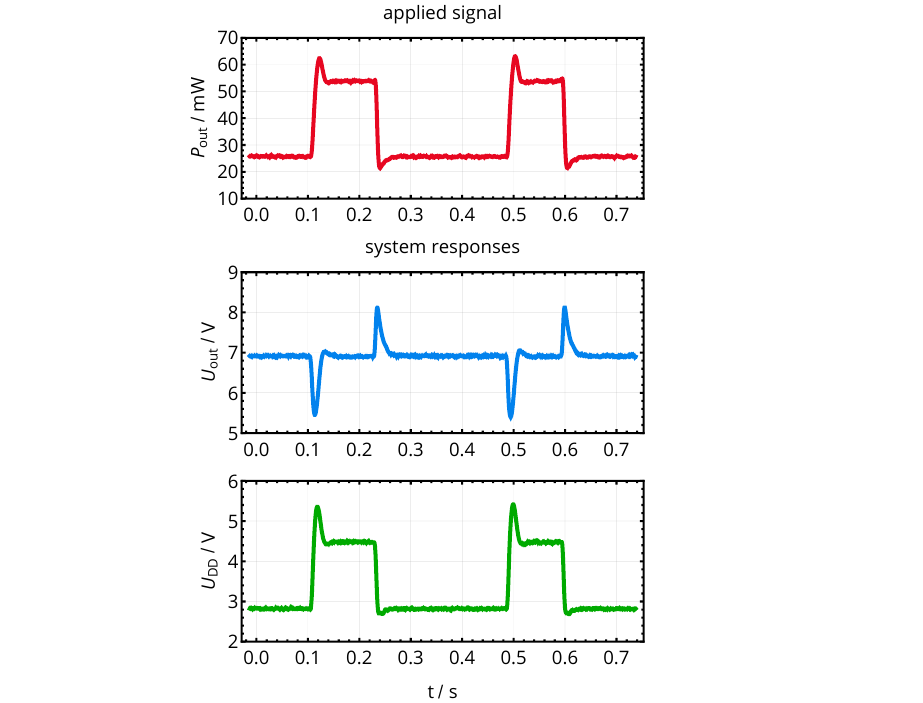
Figure 14. Reaction of the voltage controller with respect to U out and U DD due to a transient change in the load power consumption P out . For the given coil separation distance of d 12 = 20mm ( M 12 = 14nH), the target voltage of 7V is reestablished within approximately